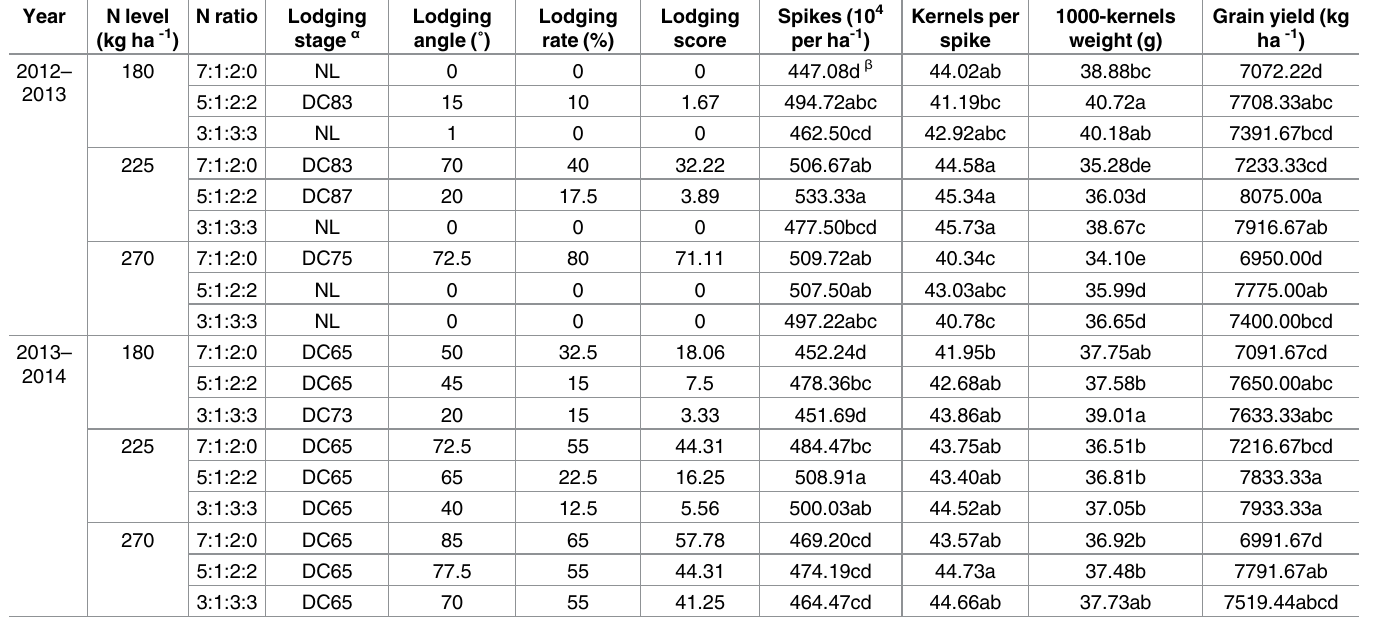
Table 1. Effect of nitrogen levels and ratios on apparent lodging rate, lodging score and grain